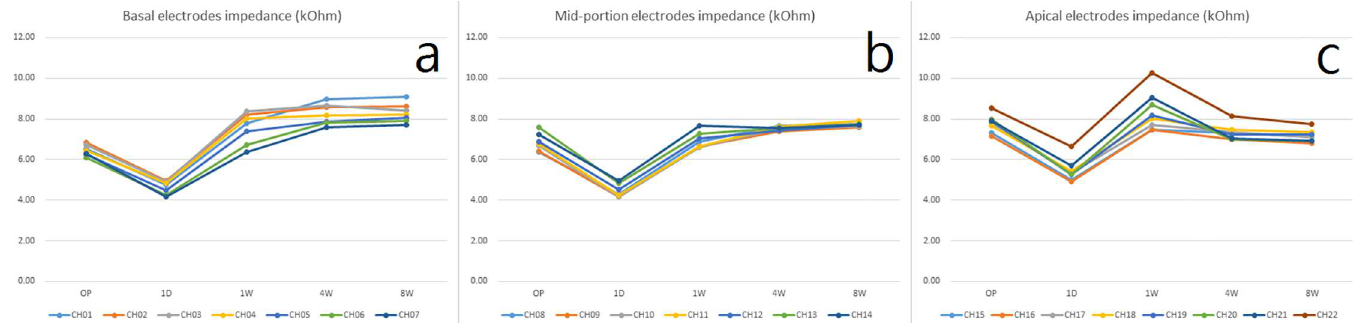
Fig 2. Evolution of electrodes impedance over 8 weeks. (a) Basal electrodes, (b) Mid-portionelectrodes, (c) Apical